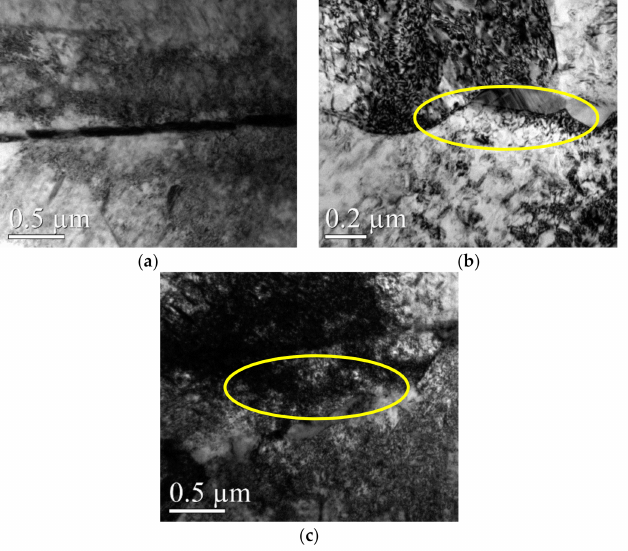
Figure 9. The change of the grain boundaries shocked by LSP at di ff erent temperatures: ( a ) 25 ◦ C, ( b ) 150 ◦ C, ( c ) 200 ◦